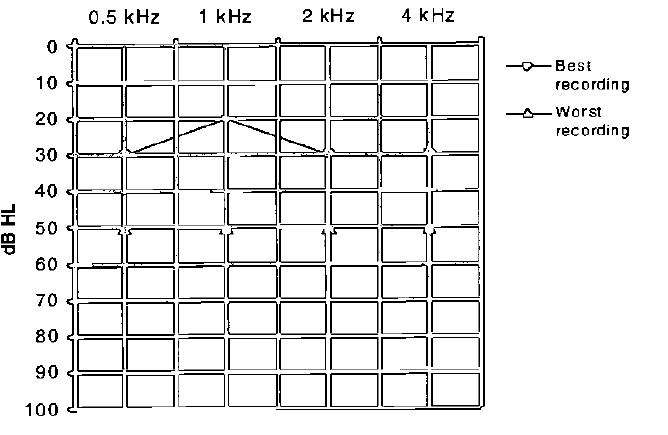
Figure -2. Best and worst ASSR estimation of normal hearing in sample of infant